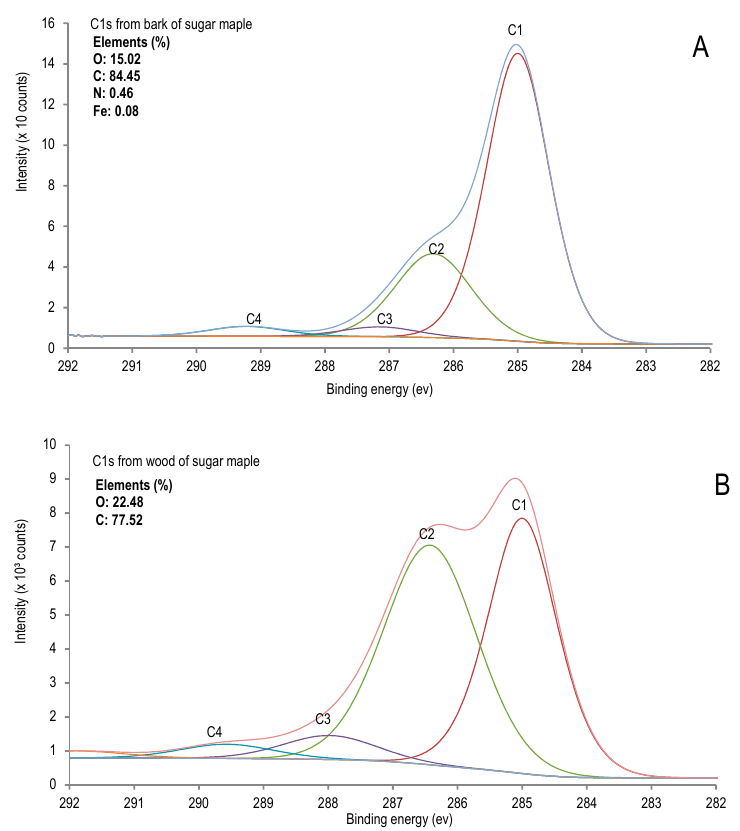
Figure 1. X-ray photoelectron spectroscopy (XPS) analysis of sugar maple. ( A ) Bark; ( B ) wood.